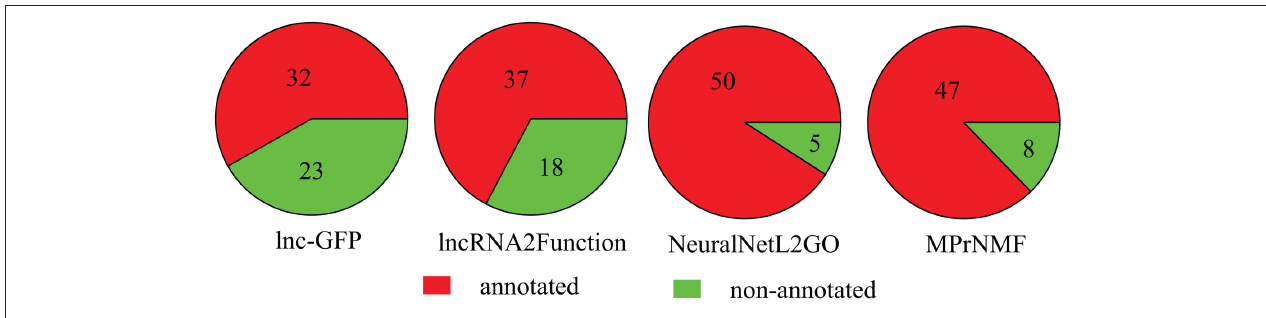
FIGURE 5 | The number of lncRNAs that are correctly annotated by various